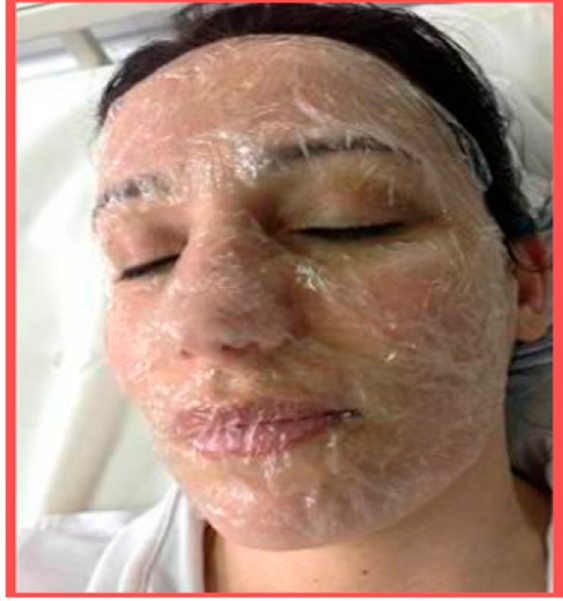
Figure 11. Chitin nanofibril-based beauty mask made by casting technology.